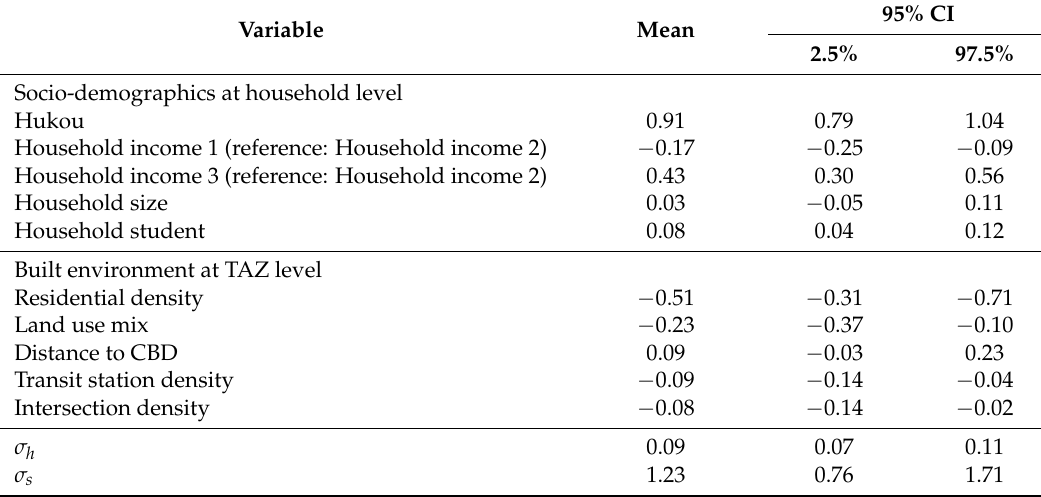
Table 3. Multilevel Bayesian Logistic regression of household car